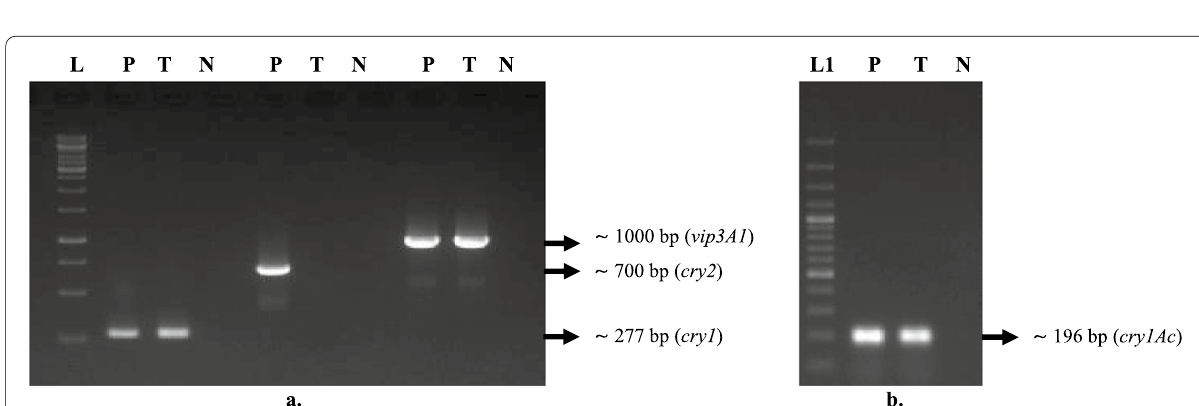
Fig. 3 a PCR amplification of cry1 , cry2 and vip3A genes, b PCR amplification of cry1Ac gene. Lane L—1 Kb DNA ladder, Lane L1—100 bp DNA ladder, Lane P—HD1, Lane T—RM11, Lane